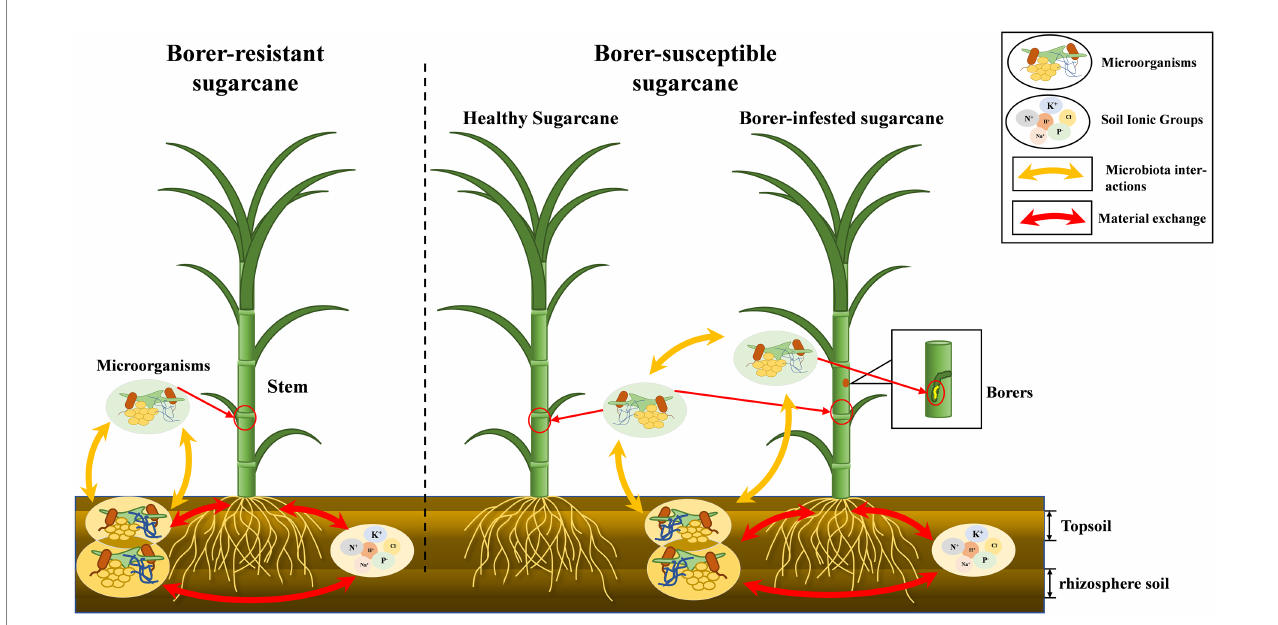
FIGURE 6 “Microbiota-plant–soil-insect” mechanism diagram. The chemical properties of the soil influence the dynamics of the Microbiome in the soil, and there is a close correlation between the aboveground and belowground soils of plants. There are differences in microbial ecology of different resistant plants. In addition, the invasion of herbivores destabilizes the original Microbiome of